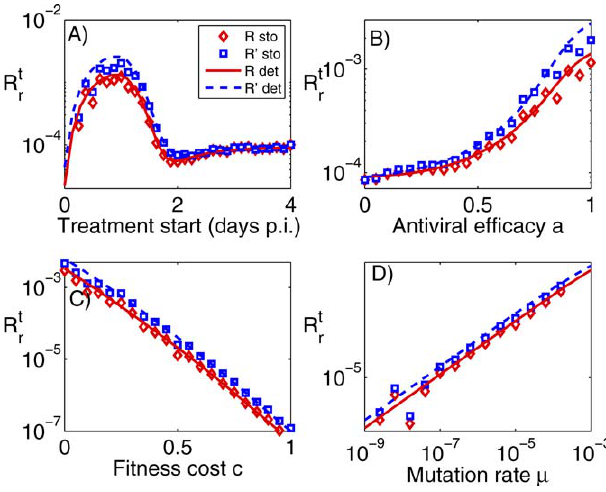
) and with ( R 9 t ) behavioral r r